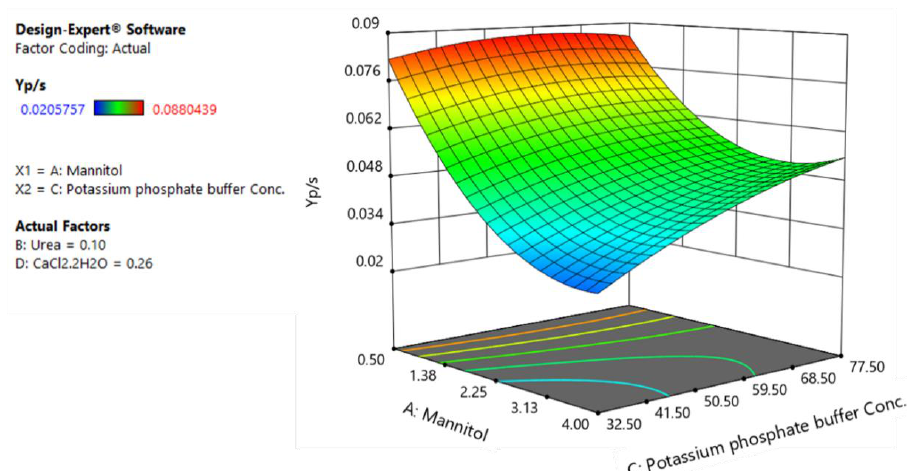
Figure 6. The response surface plot of substrate-to-product conversion yield as a function of mannitol and potassium phosphate buffer.